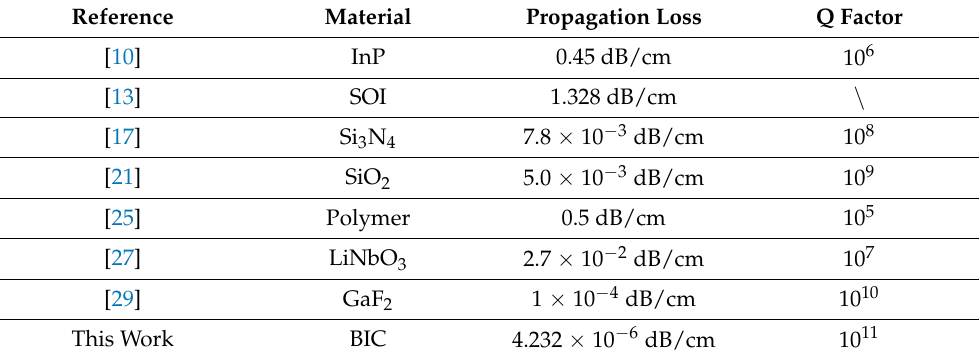
Table 1. Comparison of property of integrated optical material platforms reported in the other